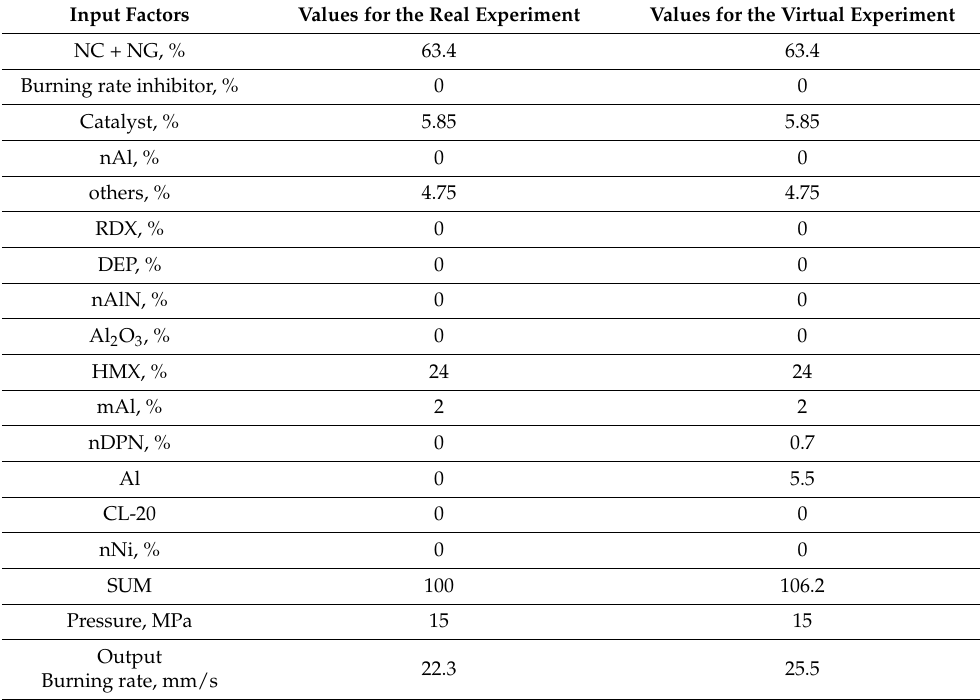
Table 3. The example of result of calculation of the ANN MCM that executes virtual experiments (right